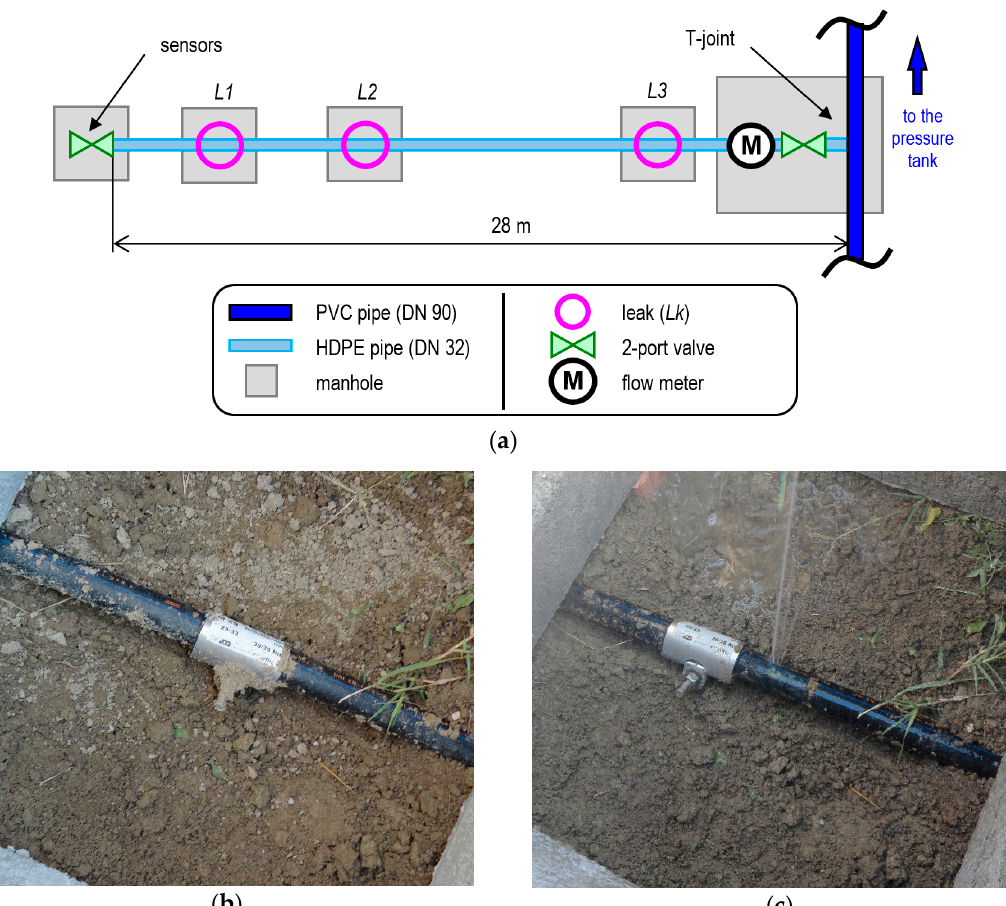
Figure 1. Test facility: ( a ) Pipeline schematics; ( b ) clamped leak; ( c ) active leak.